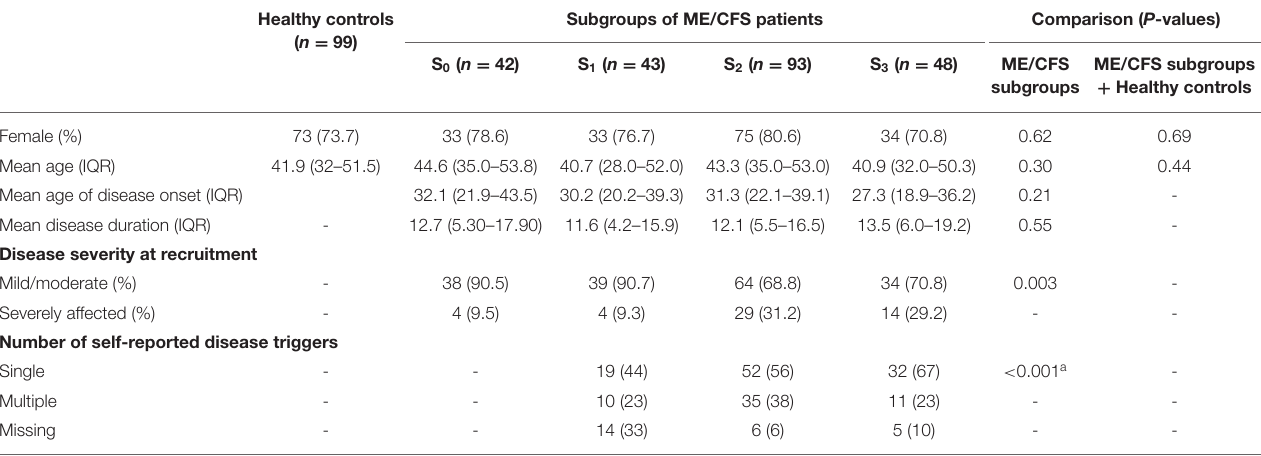
TABLE 1 | Basic characteristics of study participants where patients with ME/CFS were split into four subgroups according to the responses about their disease triggers in the symptoms’ assessment questionnaire.